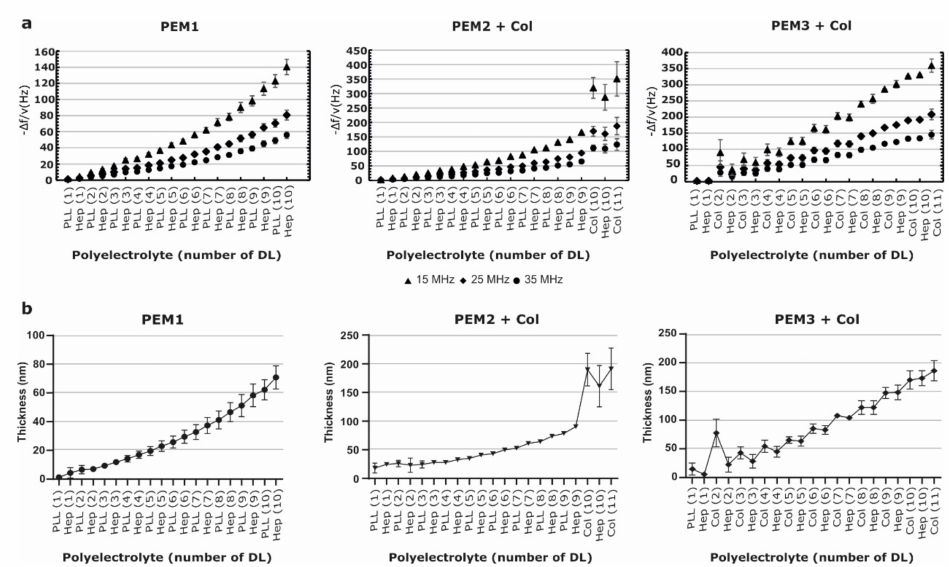
Figure 1. Online measurement of PEM film growth followed by in situ QCM-D. Shown are differences in the QCM ( a ) frequency (- ∆ f/v) and ( b ) thickness (nm) as a function of polyelectrolyte layer deposition. Brackets show the number of the accumulated bi-layers deposited on the QCM-D sensor. In ( a ) data are given for three harmonics: 15 MHz (ƒ); 25 MHz (F); and 35 MHz. Mean values are from at least three independent experiments. Each data point was calculated as mean from 10 values at the end of the deposition cycle. Each result was calculated from at least three single